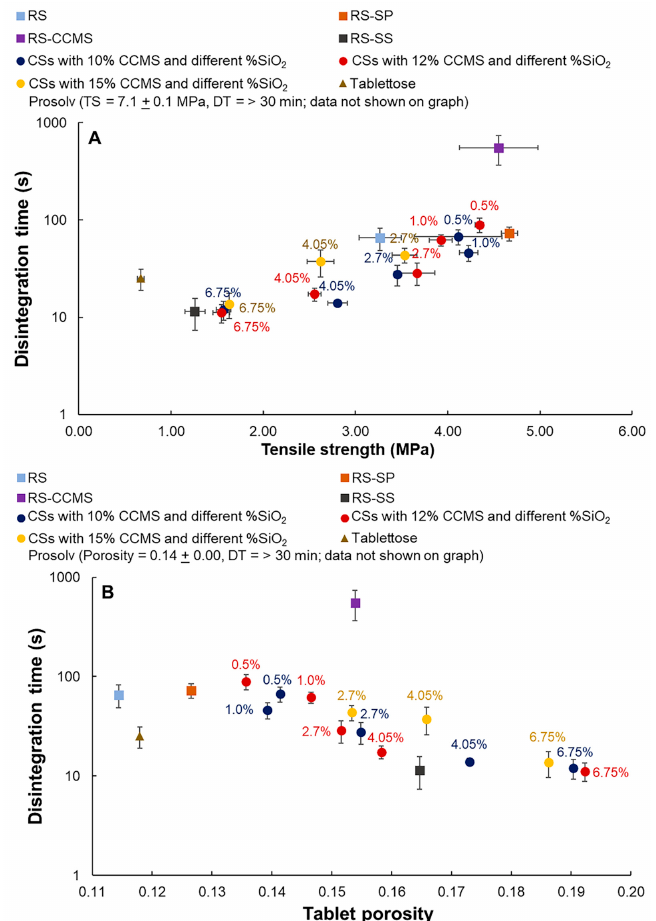
Figure 8. Effects of tablet tensile strength ( A ) and tablet porosity ( B ) on the disintegration time of rice starch and co - processed rice starch tablets.